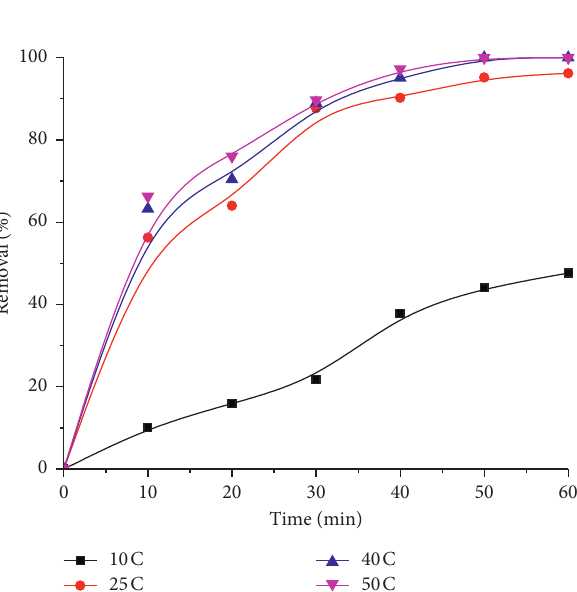
Figure 7: Effect of initial MB concentration.